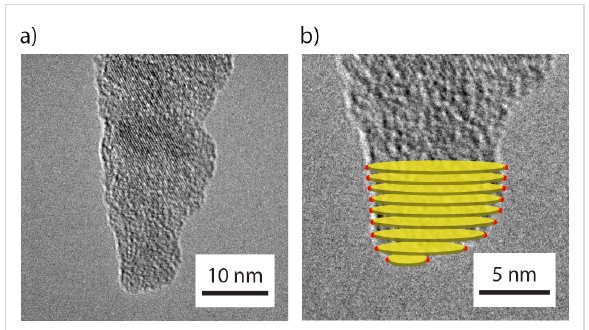
Figure 1: (a) TEM image of the apex of the AFM tip used in FM-AFM measurements. (b) Magnified TEM image of the AFM tip shown in Figure 1a. The thin yellow disks represent the methodology by which the two-dimensional tip apex profile is turned into a three-dimensional tip apex